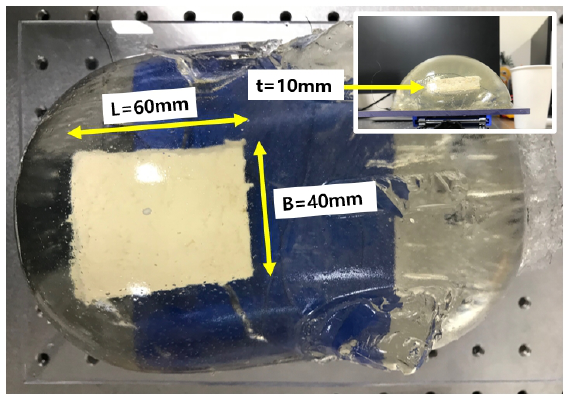
Figure 7. Bean curd-gelatin phantom (L: length, B: width, t: